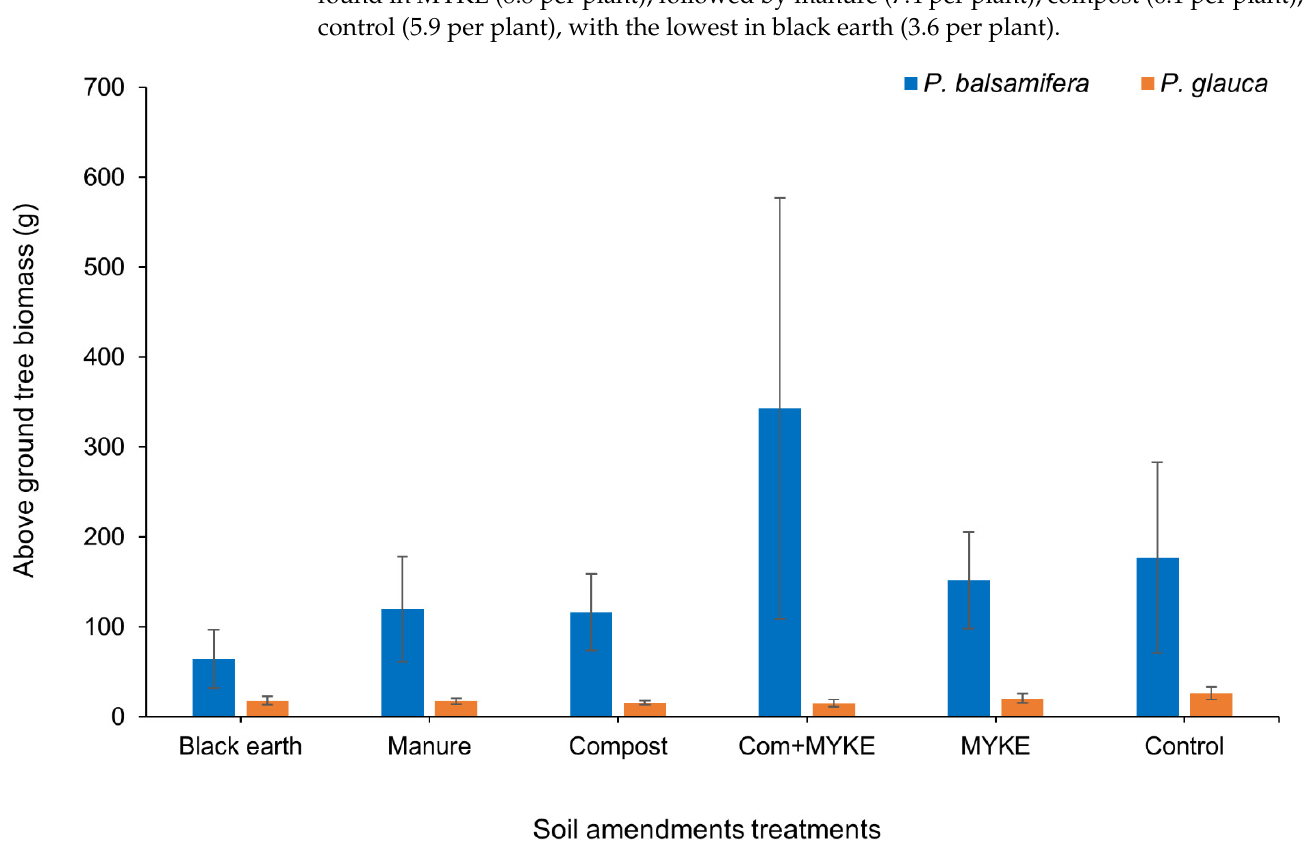
Figure 4. Mean (±SE) above-ground tree biomass of planted P. glauca and P. balsamifera by amend- Figure 4. Mean ( ± SE) above-ground tree biomass of planted P. glauca and P. balsamifera by amendment ment treatments. BE = Black earth. treatments. BE = Black